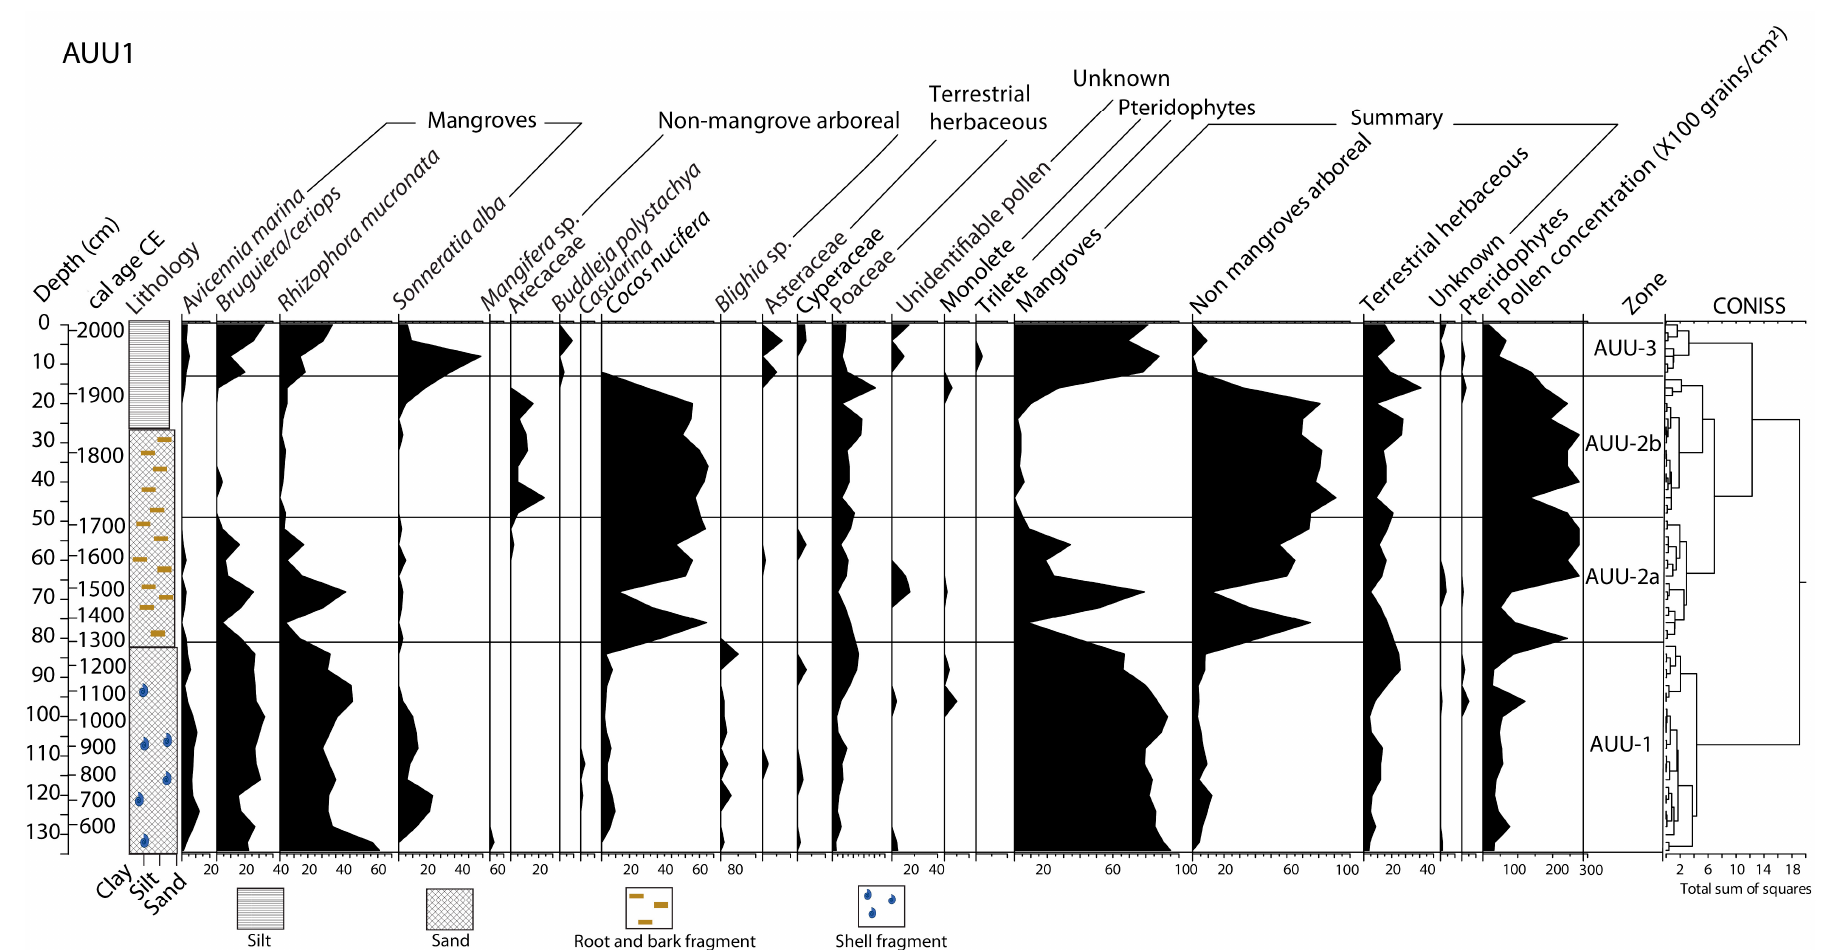
Figure 4. Pollen percentage diagram of AUU1 core.